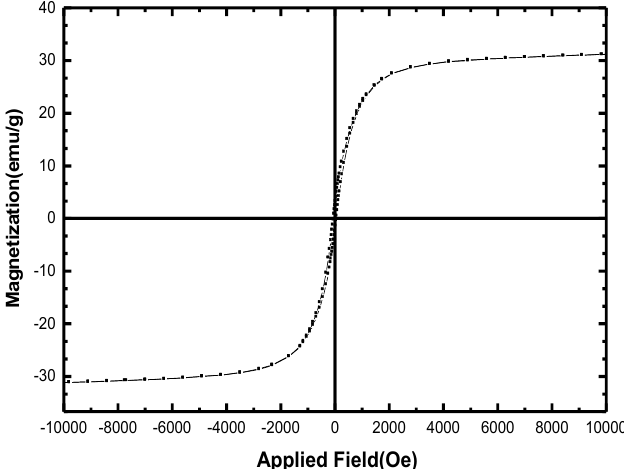
Fig. 8. Hysteresis loop of CuFe